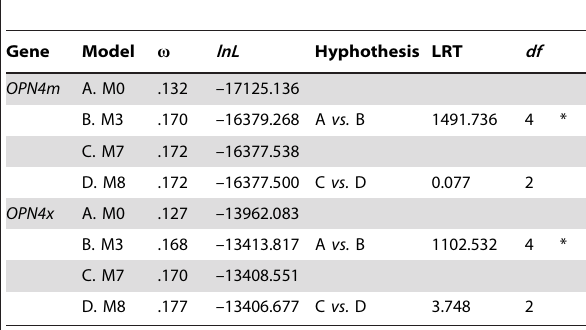
Table 1. Site-specific selection models for the vertebrate melanopsin OPN4m and OPN4x